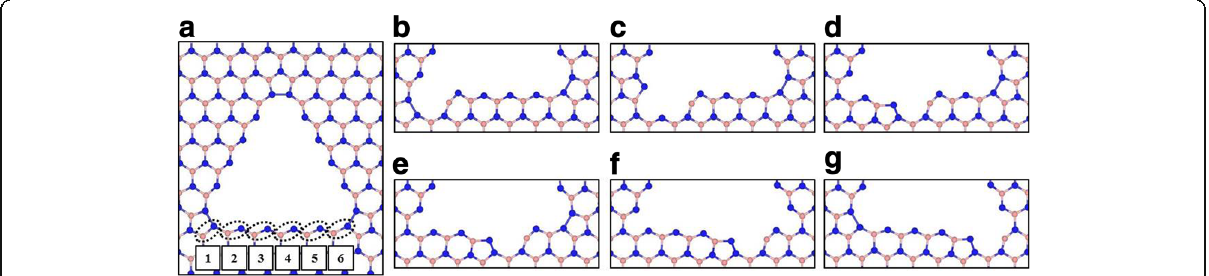
Fig. 2 Optimized structures of a V 21B+15N vacancy structure with possible missing positions of BN-pair and b – g V 22B+16N vacancy structures after a BN-pair missing at specific positions. The dotted circles with numbering in a represent possible positions of BN-pair missing. The positions with numbering 1 to 6 is denoted as b corner-1, c face-1, d face-2, e face-3, f face-4, and g corner-2 missing structures,